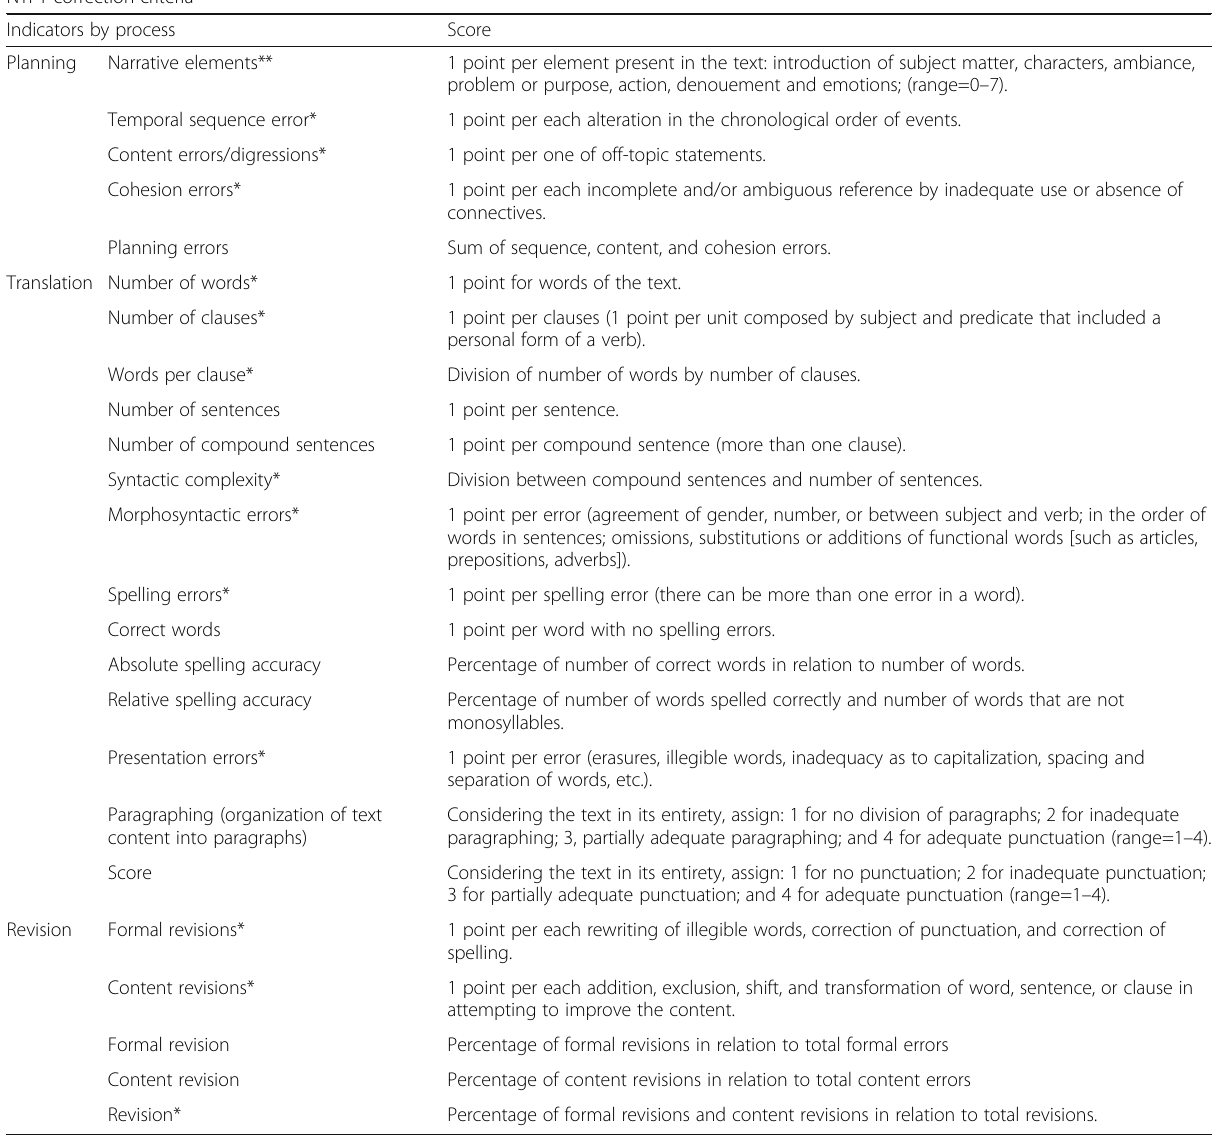
Table 4 Description of NTPT correction criteria according to writing